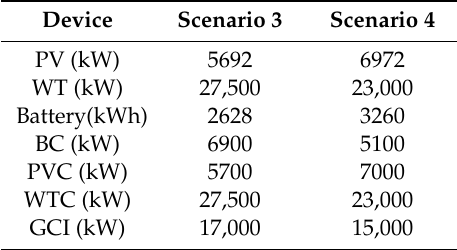
Table 9. Configuration results (single-level model).